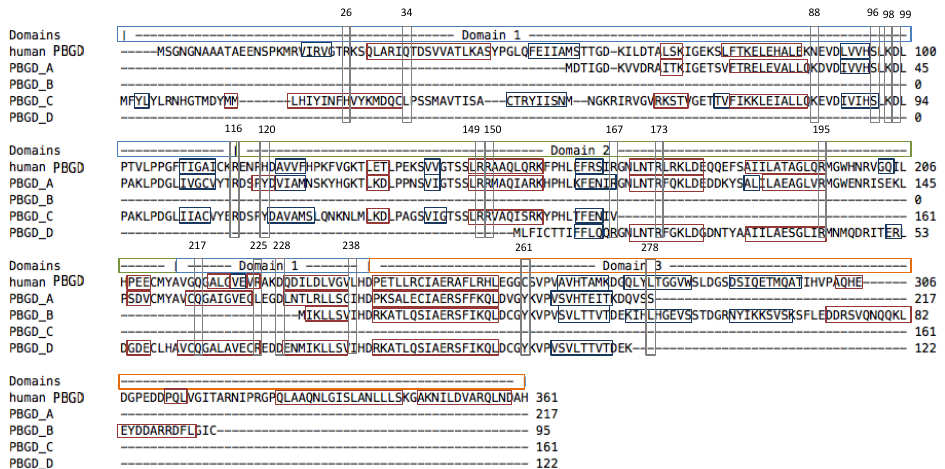
Figure 4. Alignments of the four P. margaritifera porphobilinogen deaminase (PBGD) (PBGD_A to PBGD_D) against the human PBGD (Song et al. 2009). The pale blue boxes correspond to domain 1, the green to domain 2 and the orange to domain 3. Red boxes show α helix (H) and dark blue boxes β strands (S). Grey boxes correspond to key residues (amino acids).